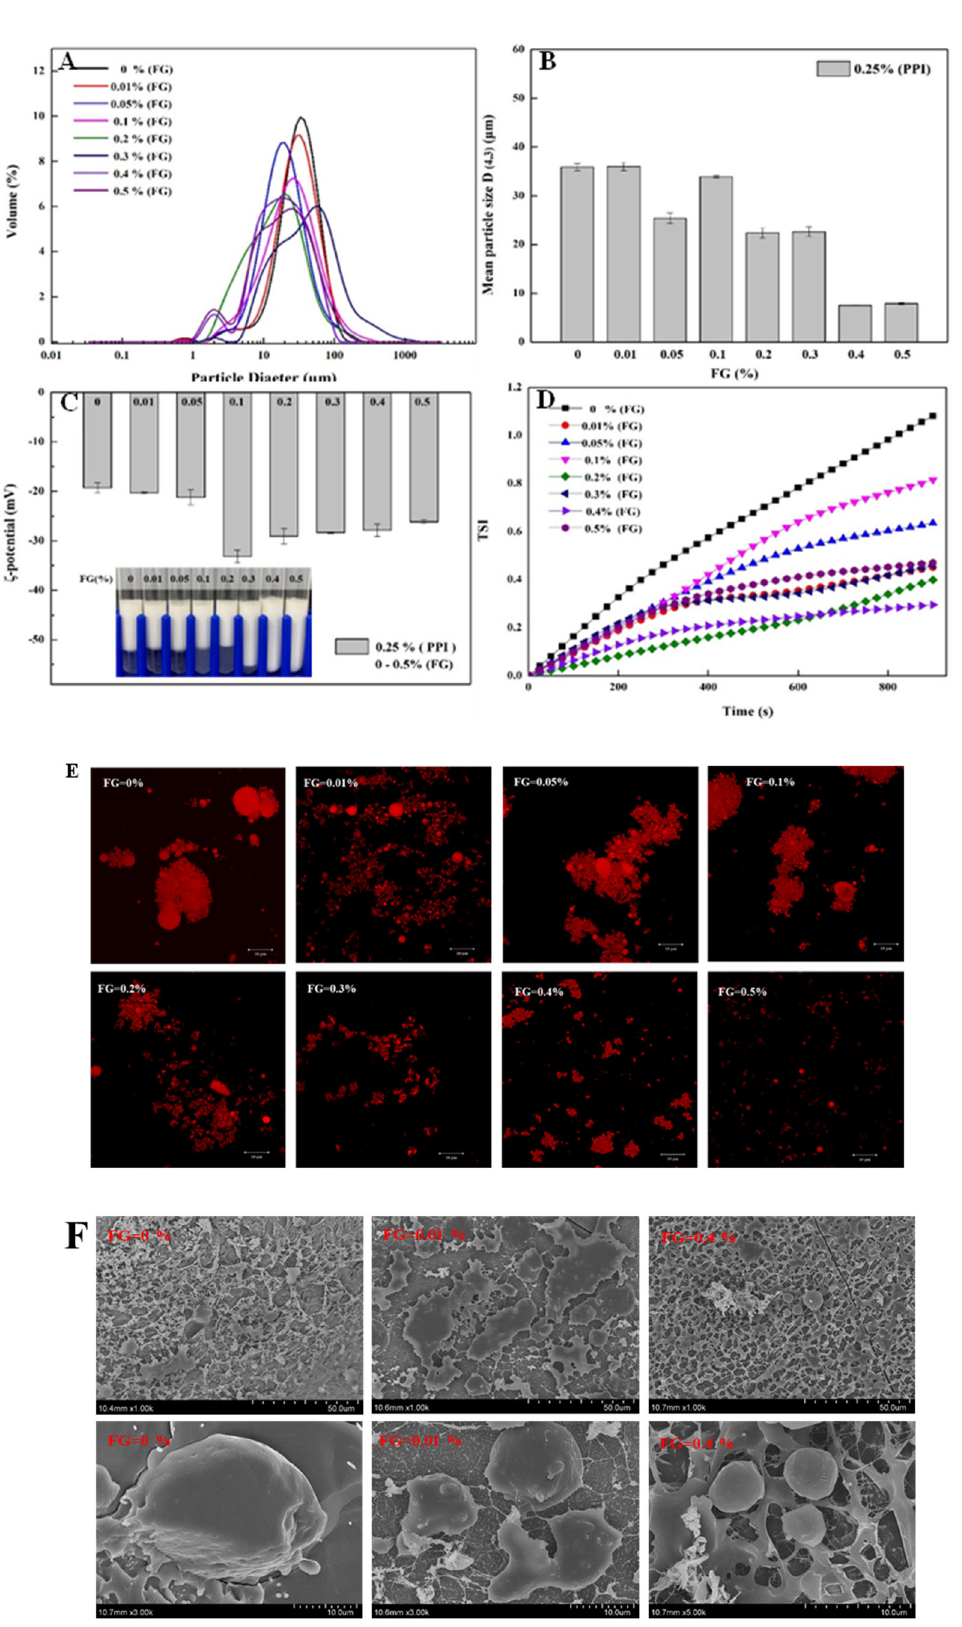
Figure 3. Effect of FG concentration on related properties: ( A ) particle size distribution, ( B ) average droplet size, ( C ) ζ -potential and appearance diagram, ( D ) Turbiscan stability index (TSI), ( E ) CLSM and ( F ) SEM images .